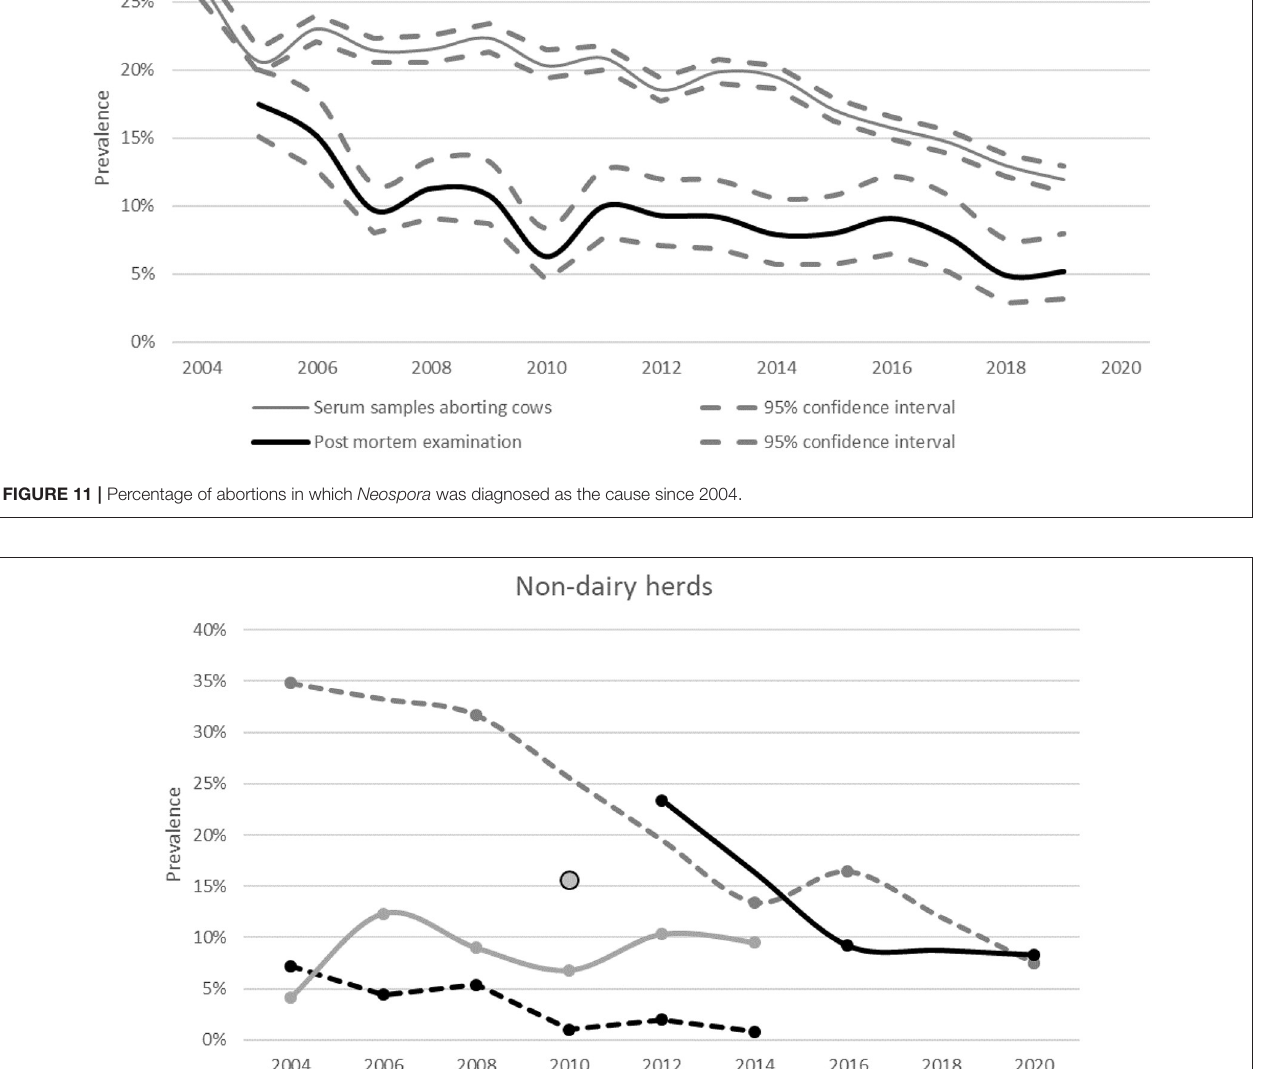
results of serological sampling in aborting cattle at Royal GD.